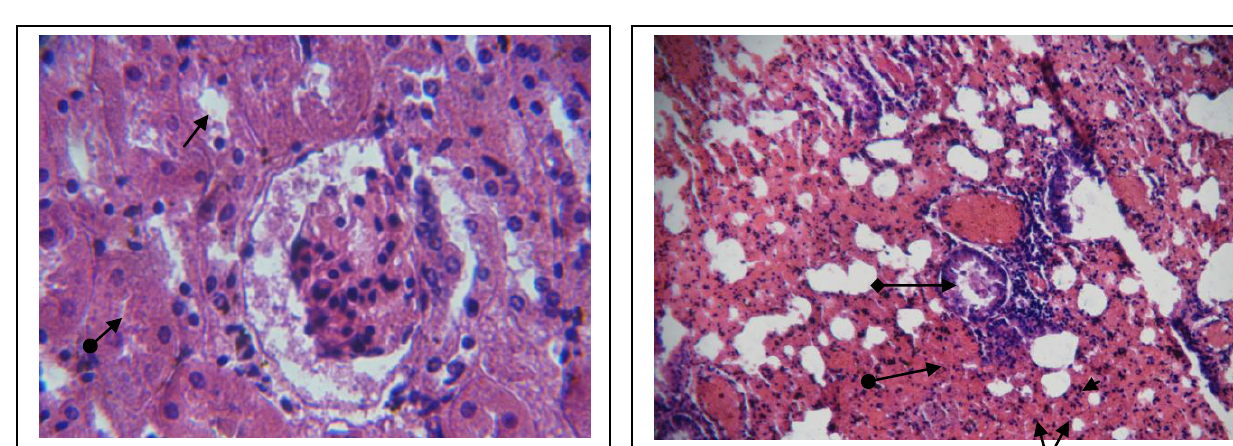
figure(2): There is coagulative necrosis( ) and lymphatic aggregation in the liver( ) . (H&E ×10).